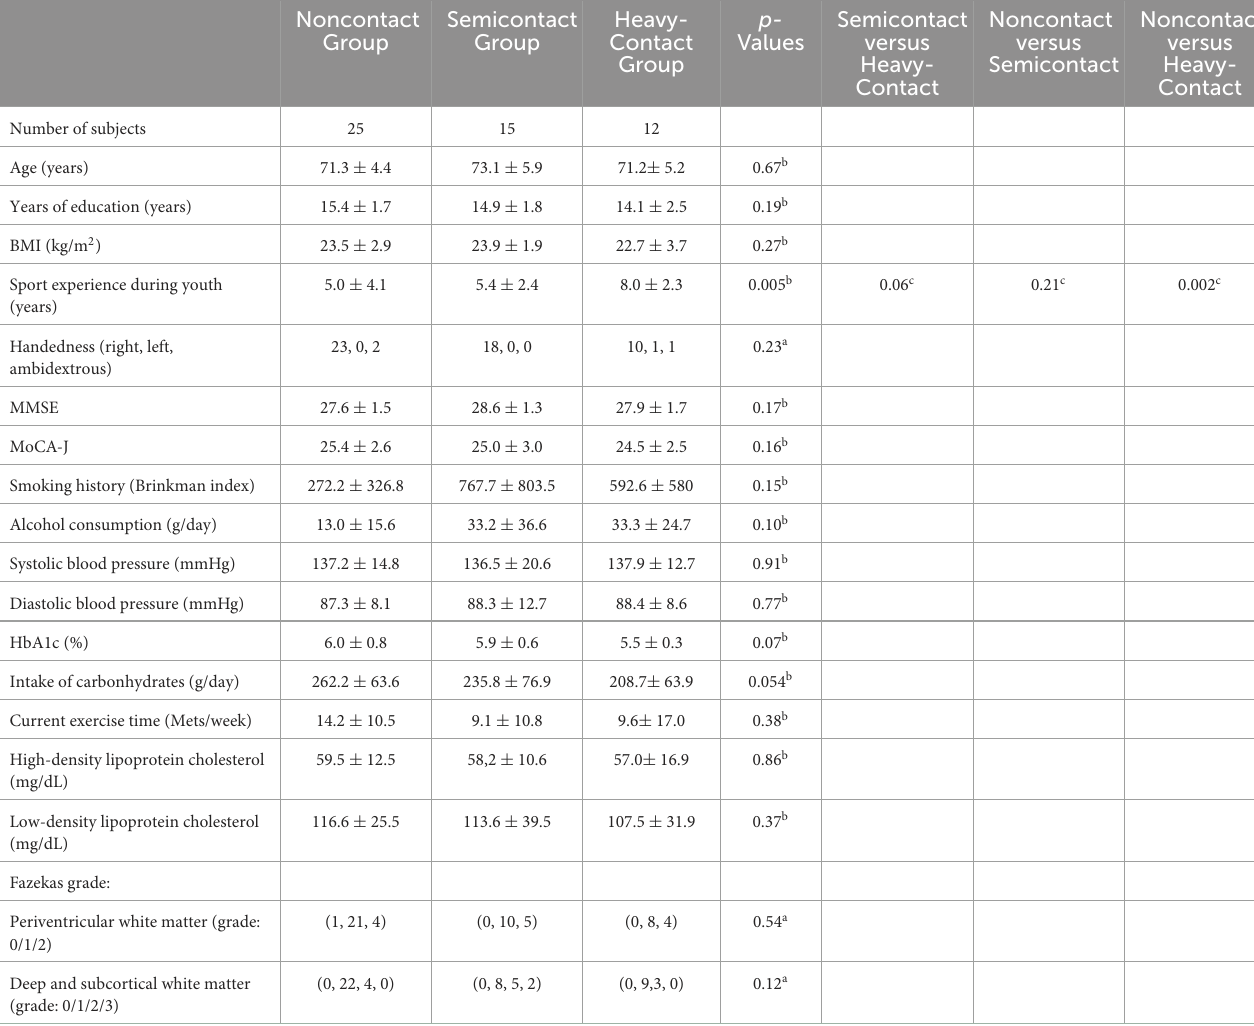
TABLE 1 Demographic and clinical characteristics of the study